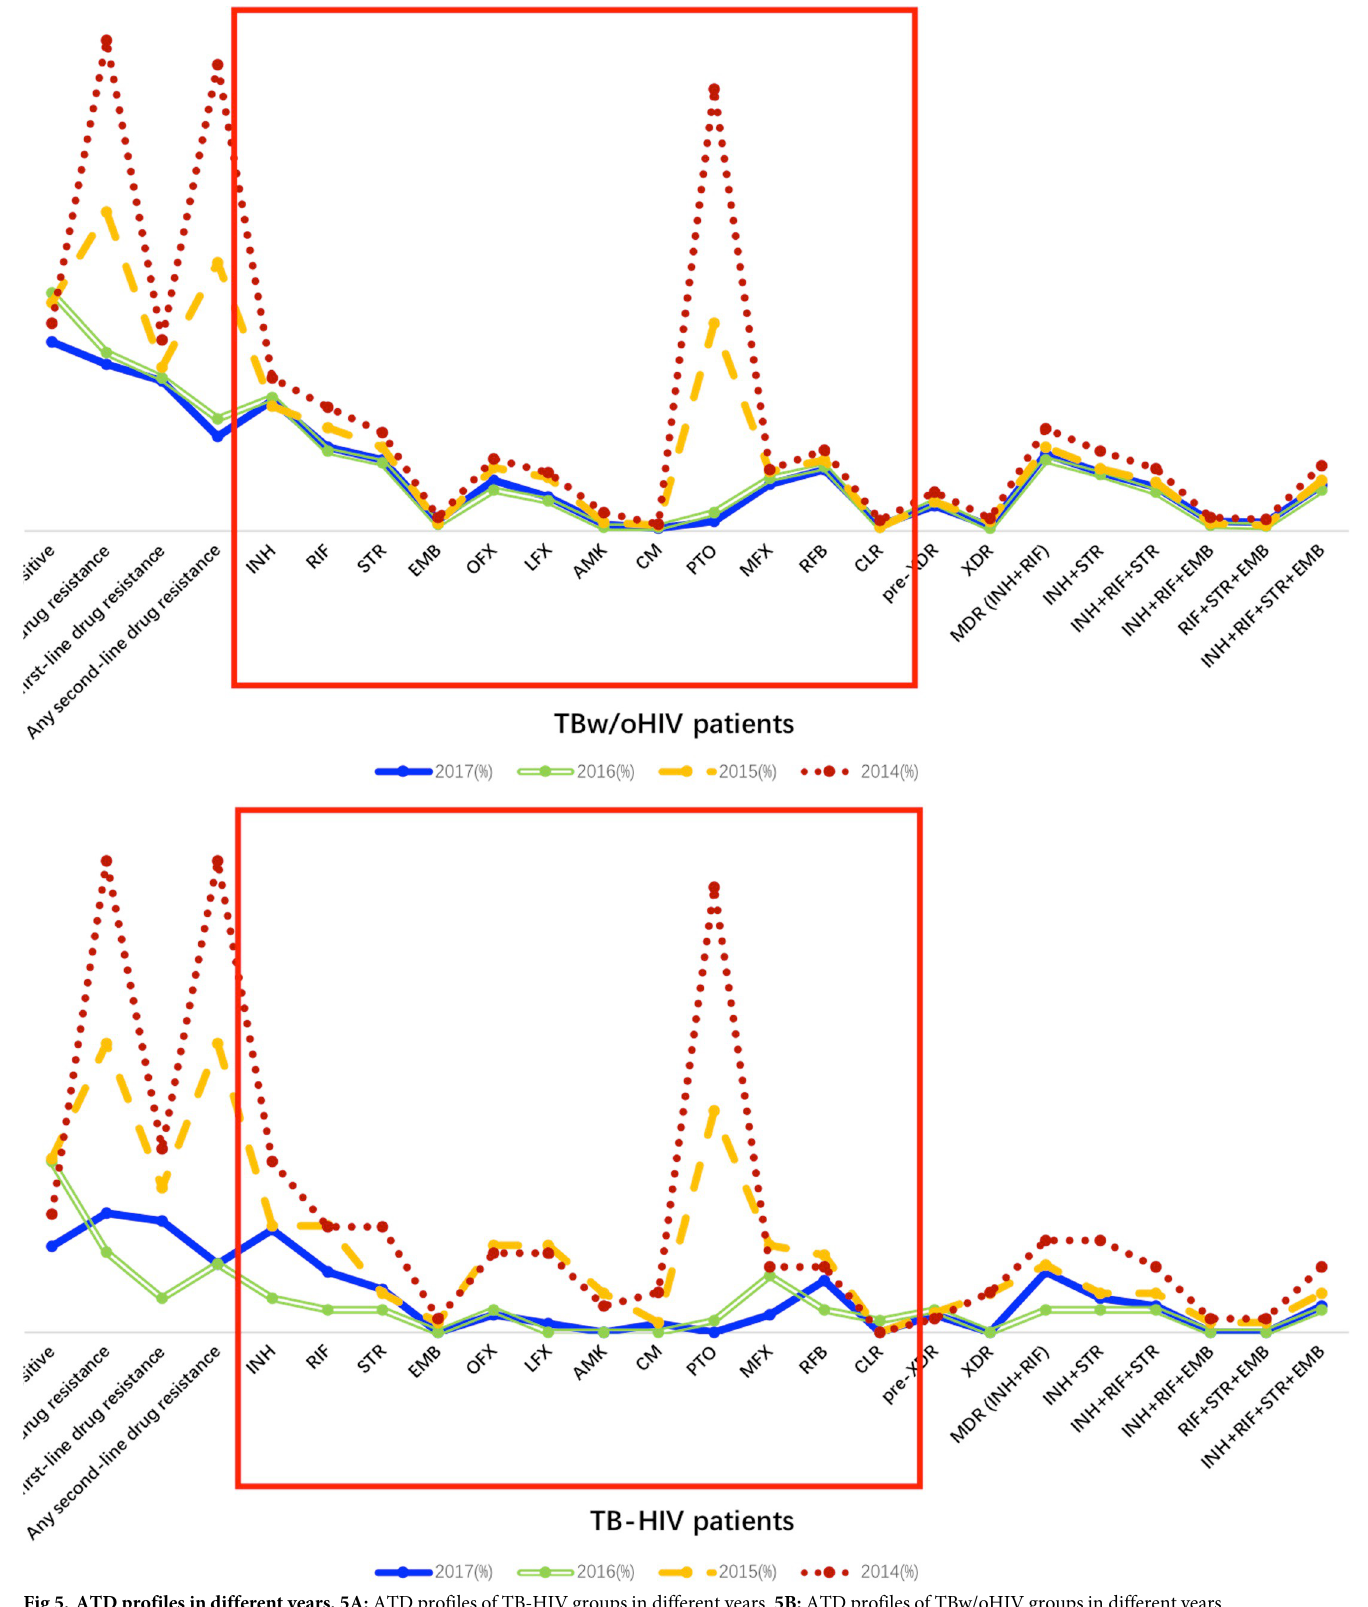
Fig 5. ATD profiles in different years. 5A: ATD profiles of TB-HIV groups in different years. 5B: ATD profiles of TBw/oHIV groups in different years.